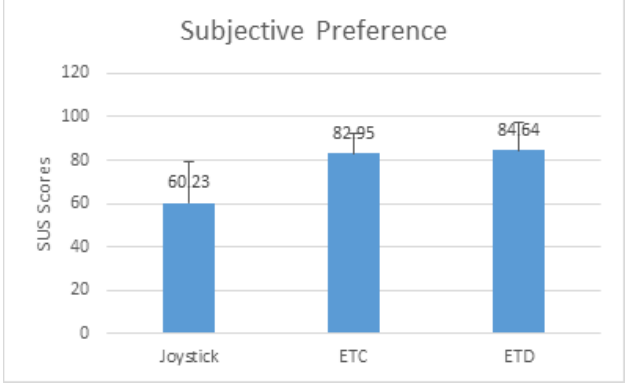
Figure 37. Analysing subjective preference in the flight simulator.